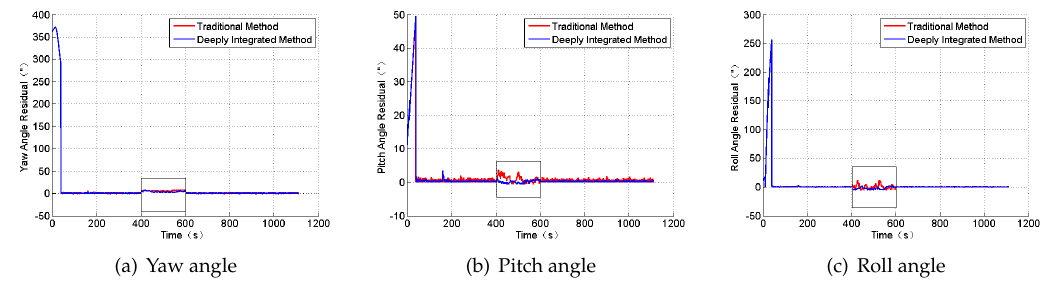
Figure 7. The attitude angle